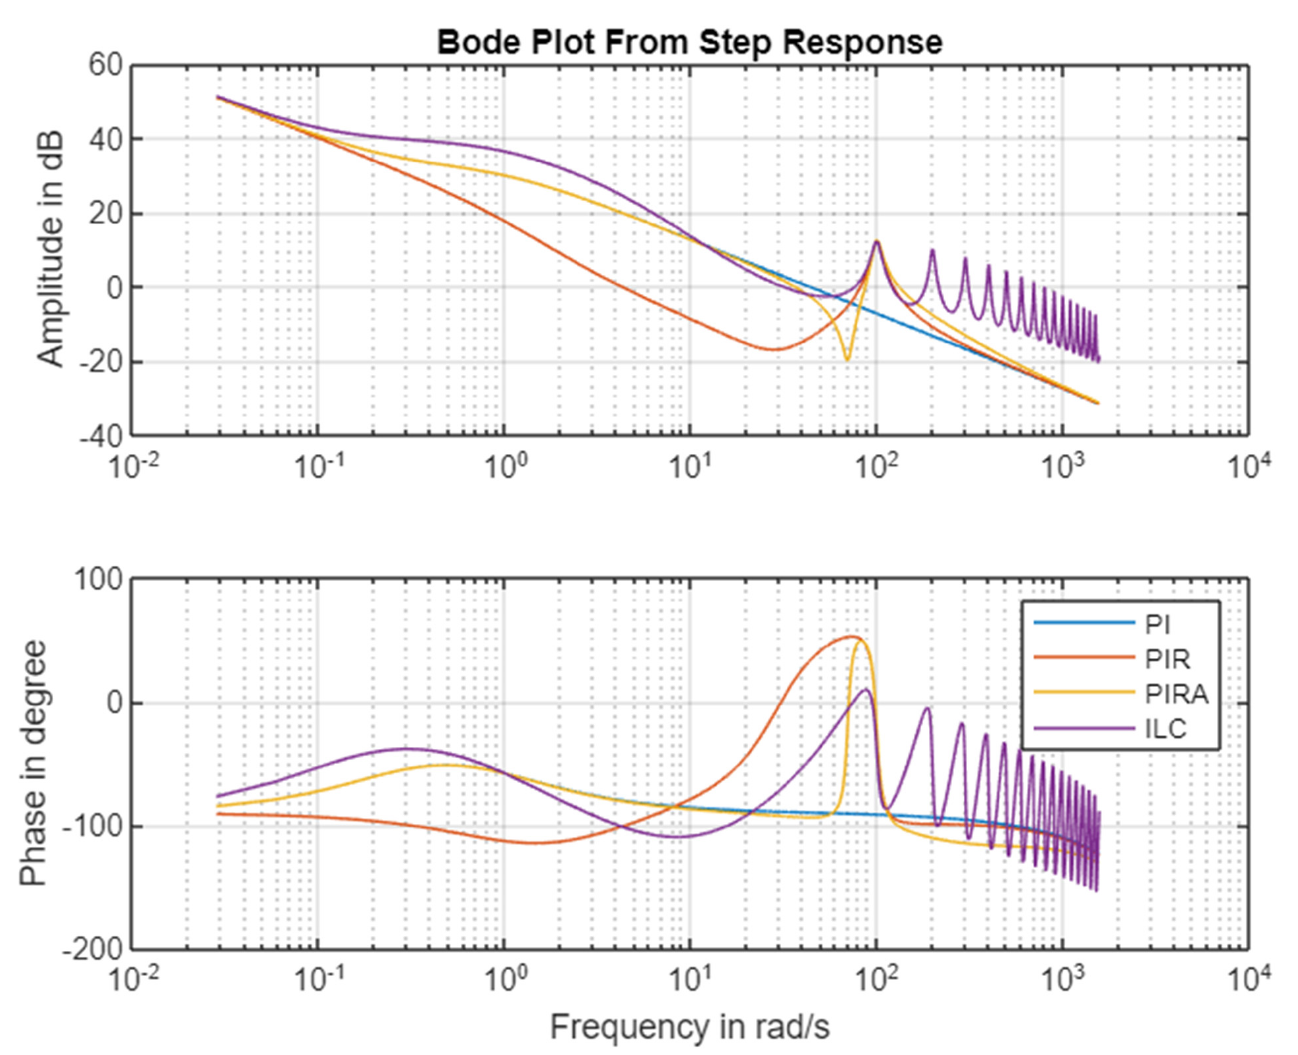
Figure 9. Comparing the Bode Plot of the open loop chain for the three controllers. The plots highlights both key similarities and differences between the approaches.